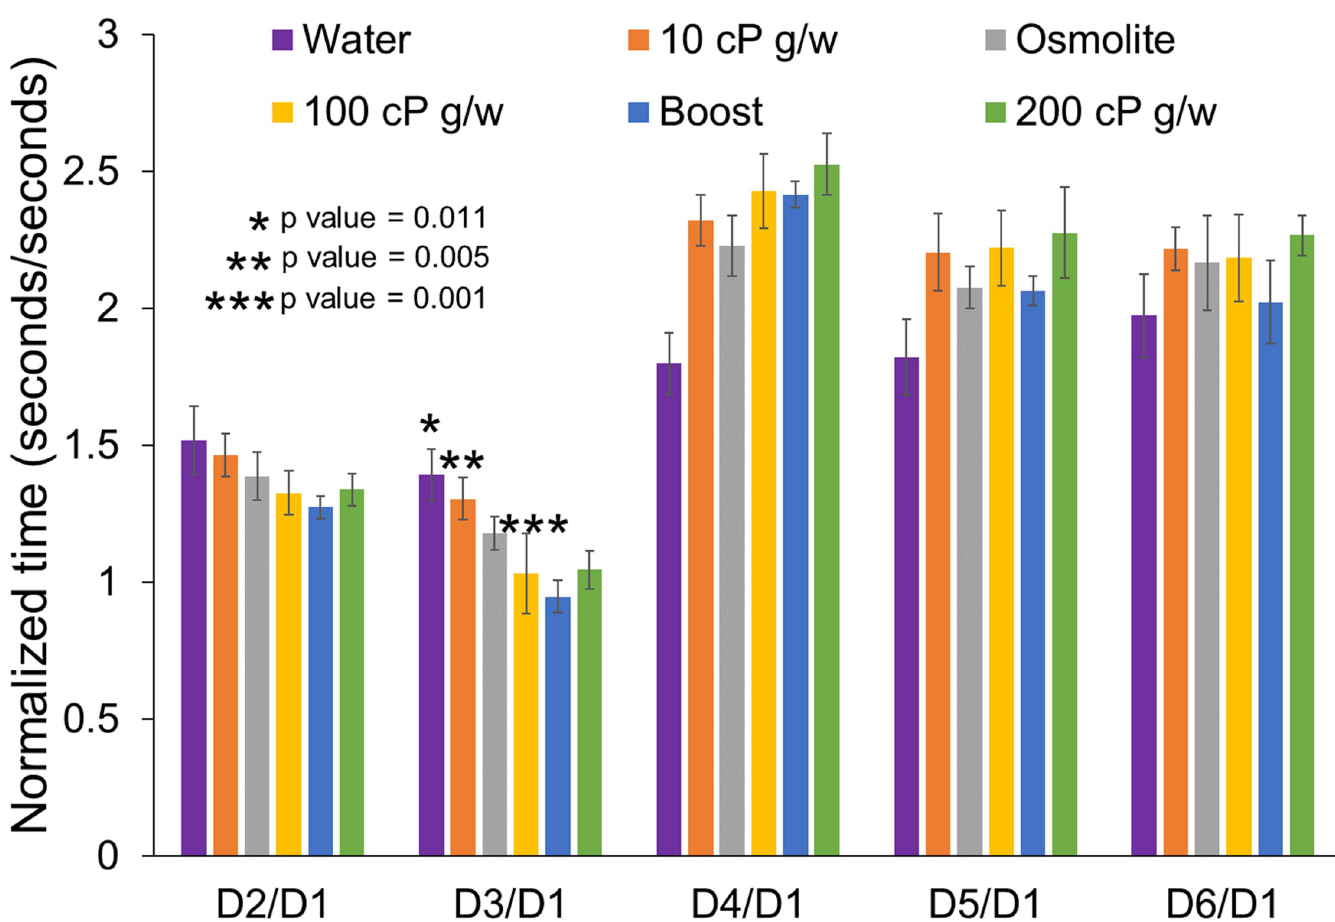
Fig 3. Normalized time required by each surrogate device design. Time required by device normalized with the time required by D1 for six different fluids. The data are then grouped together for different diets with the same surrogate